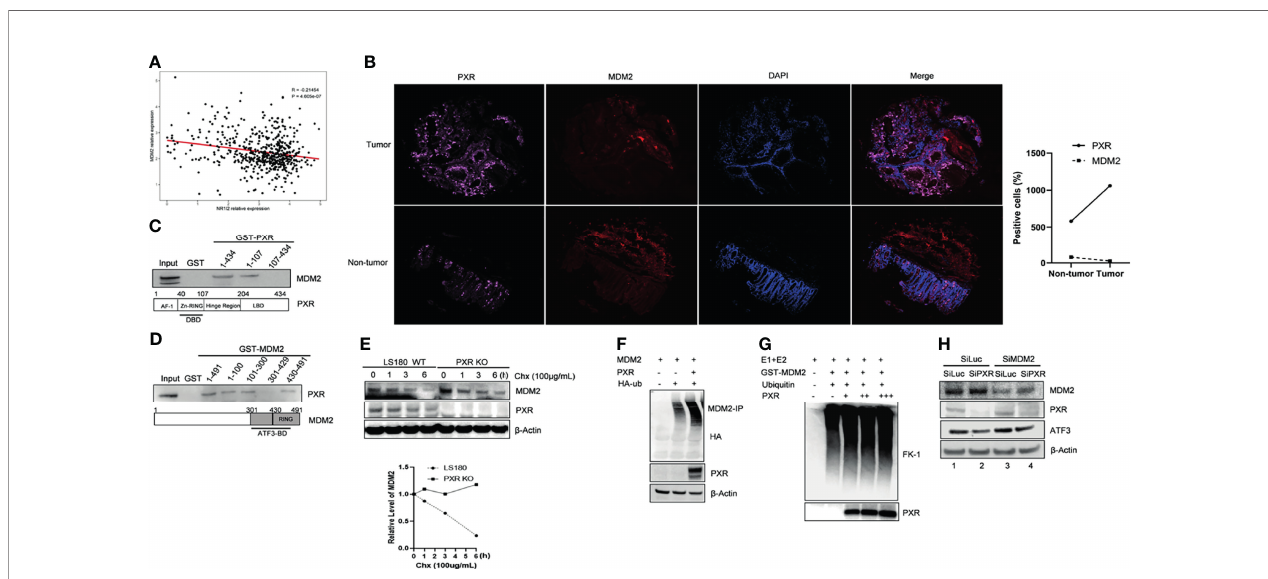
FIGURE 5 | PXR interacts with MDM2 and negatively regulate expression of MDM2. (A) mRNA expression of PXR negatively correlated with mRNA expression of MDM2. 151 colorectal samples from TCGA database were collected and analyzed the correlations between mRNA level of PXR and that of MDM2. (B) PXR, MDM2 immuno fl uorescence staining in matched samples of human colon adenocarcinoma tissue and adjacent non-tumor tissue. The right panel shows the statistics of positive staining cells. n = 50 for each group. (C) The DBD contains zinc- fi nger region of PXR physically interacted with MDM2. Truncated PXR were immobilized with GST and incubated with in vitro translated MDM2 and subjected with GST-pulldown to map the region of PXR binding with MDM2. (D) PXR physically interacted with MDM2 on the RING domain. Truncated MDM2 were immobilized with GST and incubated with in vitro translated PXR and subjected with GST- pulldown to map the region of MDM2 binding with PXR. (E) PXR reduced MDM2 protein half-life in colon cancer cells. LS180 wild-type and PXR knockout cells were treated with 100 m g/mL cycloheximide (CHX), harvested at different time point, and then Western blotting was performed to detect MDM2 half-life alteration. Relative MDM2 levels were quantitated by densitometry and presented in the right plot. (F) Ubiquitination of MDM2 was enhanced by addition of PXR. H1299 cells were transfected with 0.5 m g HDM2, 1 m g HA-ubiquitin, and/or 2 ug PXR plasmids, then MDM2-immunoprecipitation was performed with HA antibody to probe. (G) PXR increased polyubiquitination of MDM2 in a dose-dependent manner. E1, E2, and GST-MDM2 (E3) were incubated with ubiquitin for 3 h at 4°C, and 0.5 m g, 1 m g, 3 m g recombinant PXR was then added as indicated and incubated for another 3 h. The protein levels were determined by Western blotting. FK-1 antibody was used to detect polyubiquitination. (H) MDM2 inhibition by siRNA abolished knockdown of PXR mediated downregulation of ATF3 expression. LS180 cells were transfected with 20 nM SiLuc or SiMDM2 for 24 h and then transfected with 20 nM SiLuc or SiPXR for 48 h. Then cells were collected and lysed, and the PXR, MDM2 and ATF3 protein levels were determined using Western